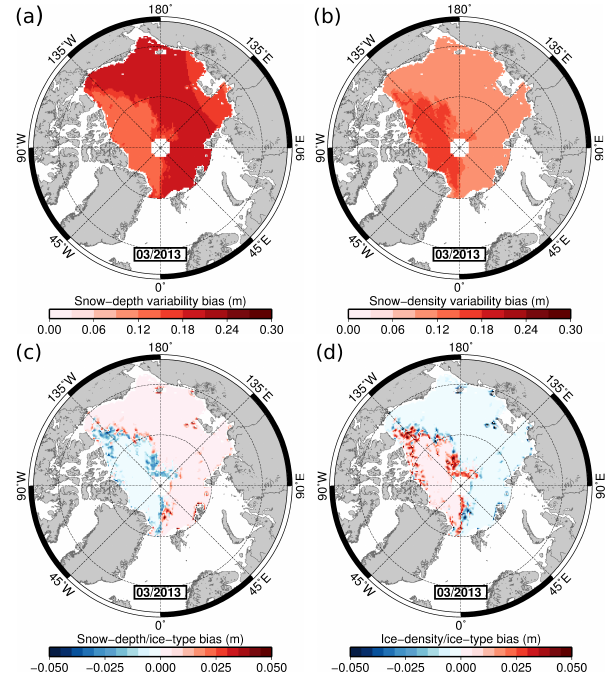
Figure 13. Contribution to the sea-ice thickness bias originating from (a) snow-depth variability, (b) snow-density variability and ice-type-induced uncertainties of (c) snow depth and (d) ice den-